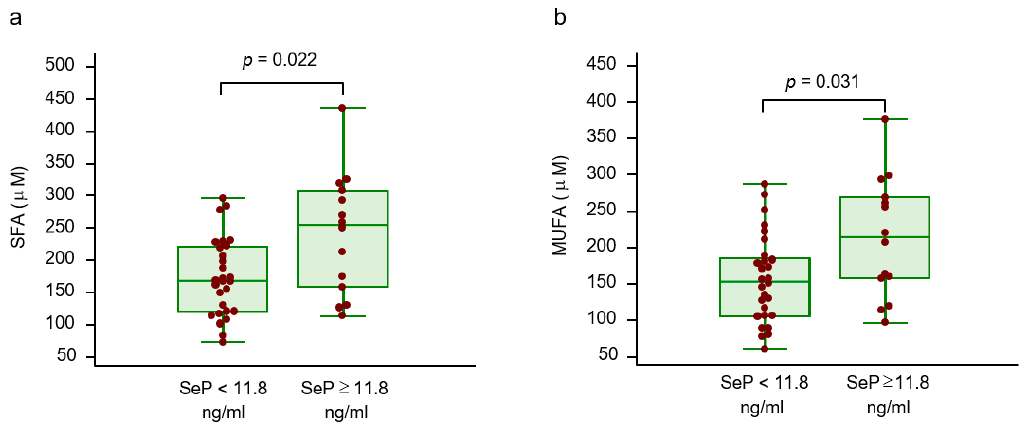
Figure 2. Saturated ( a ) and monounsaturated ( b ) fatty acid levels are reported according to selenoprotein P cut-off, corresponding to the 75th percentile (11.8 ng/mL). Abbreviations: monounsaturated free fatty acids (MUFA), selenoprotein P (SeP), saturated free fatty acids (SFA).